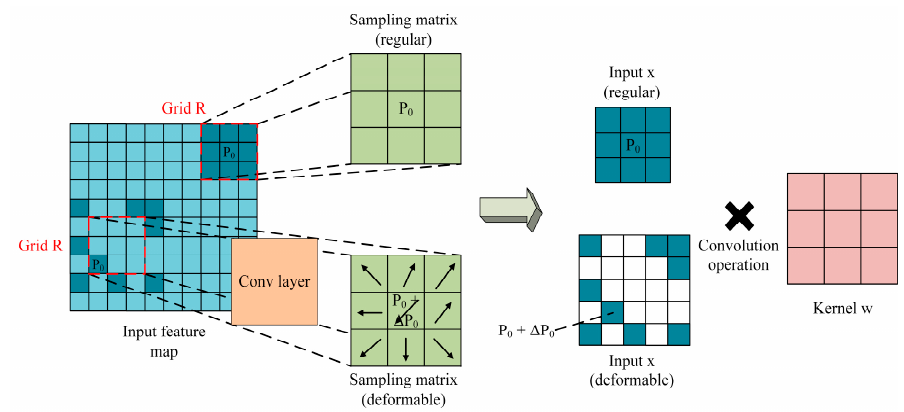
Figure 6. Illustration of 3 × 3 regular and deformable convolution process.